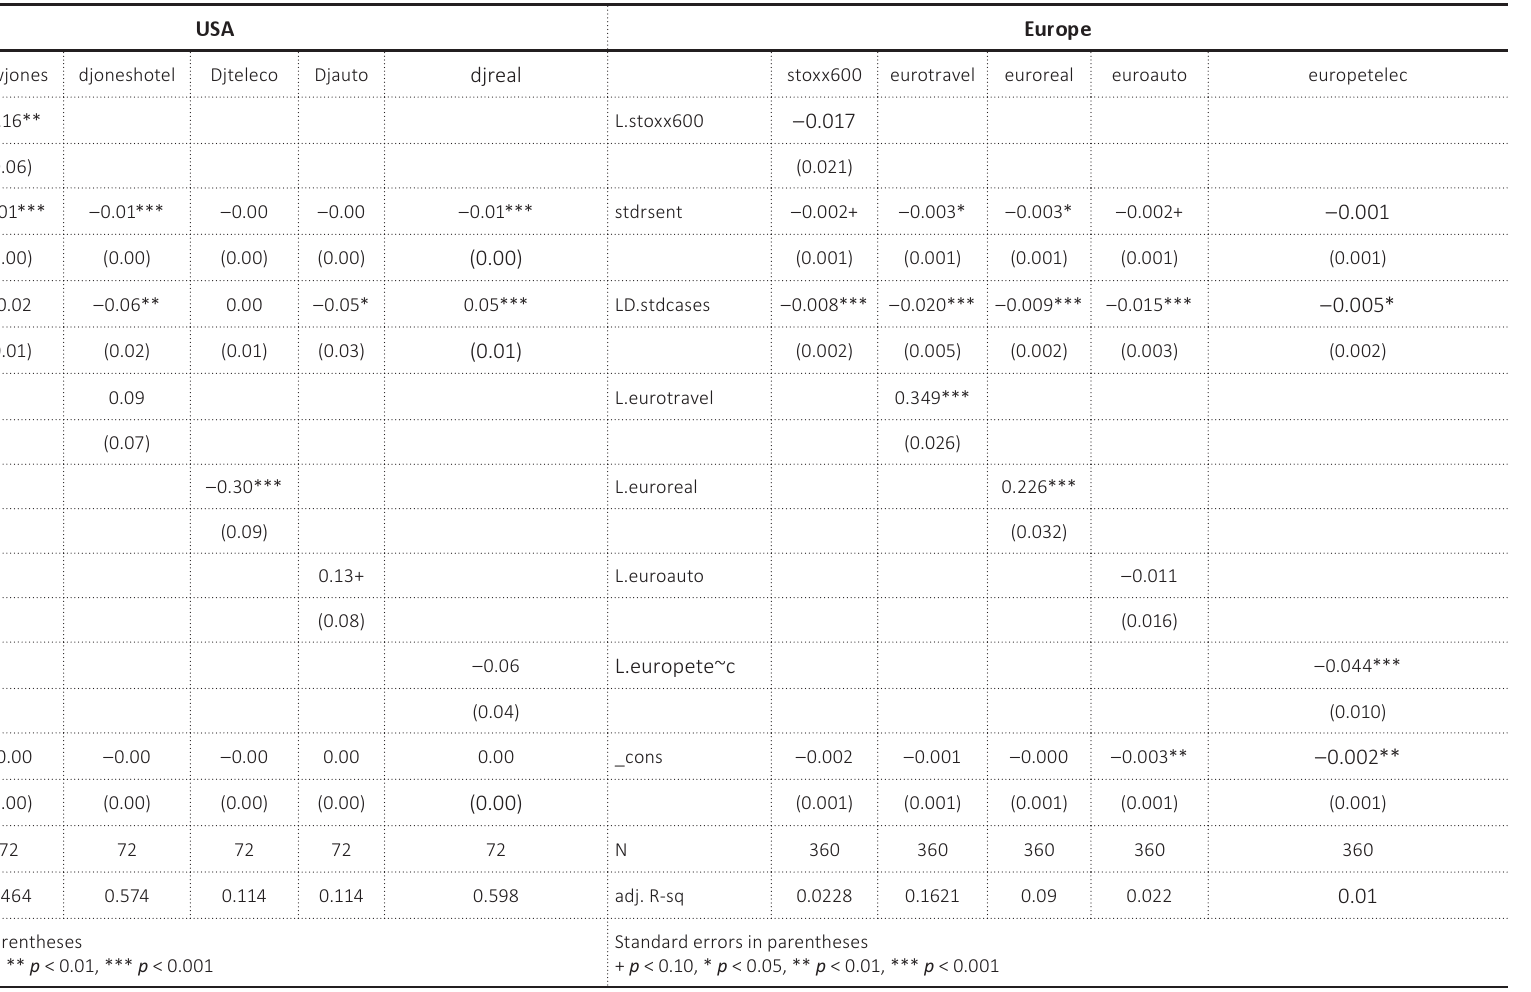
Table 3. Random effects panel regression results for the US and